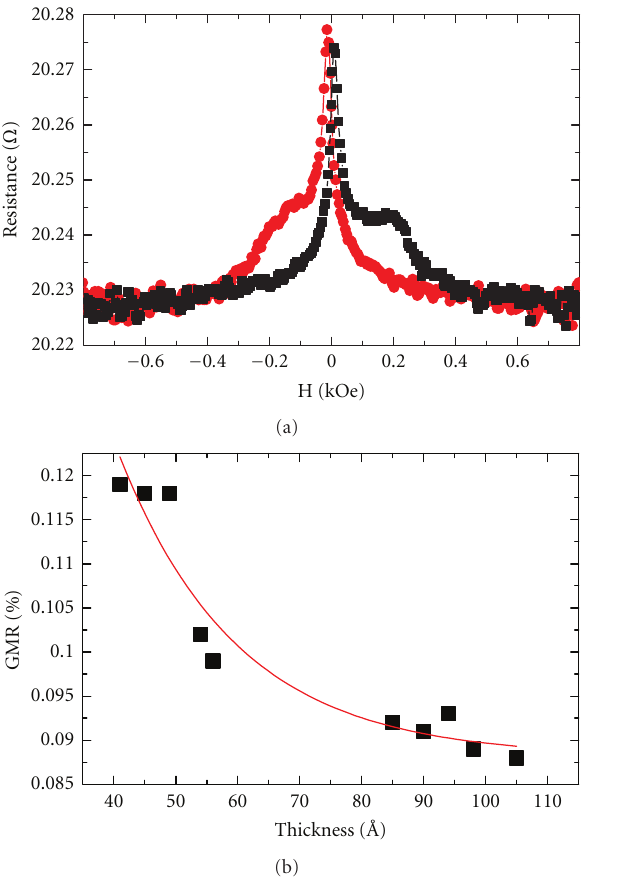
Figure 7: (a) Current in plane magnetoresistance measurements on Fe 3 O 4 (500 ˚A)/Cr(57 ˚A)/Fe 3 O 4 (1000 ˚A) spin valves. The black (red) data are measurements with increasing (decreasing) fields. (b) Change of GMR as a function of Cr spacer layer thickness; the line is a fit to an exponential decay, with a decay constant of 33